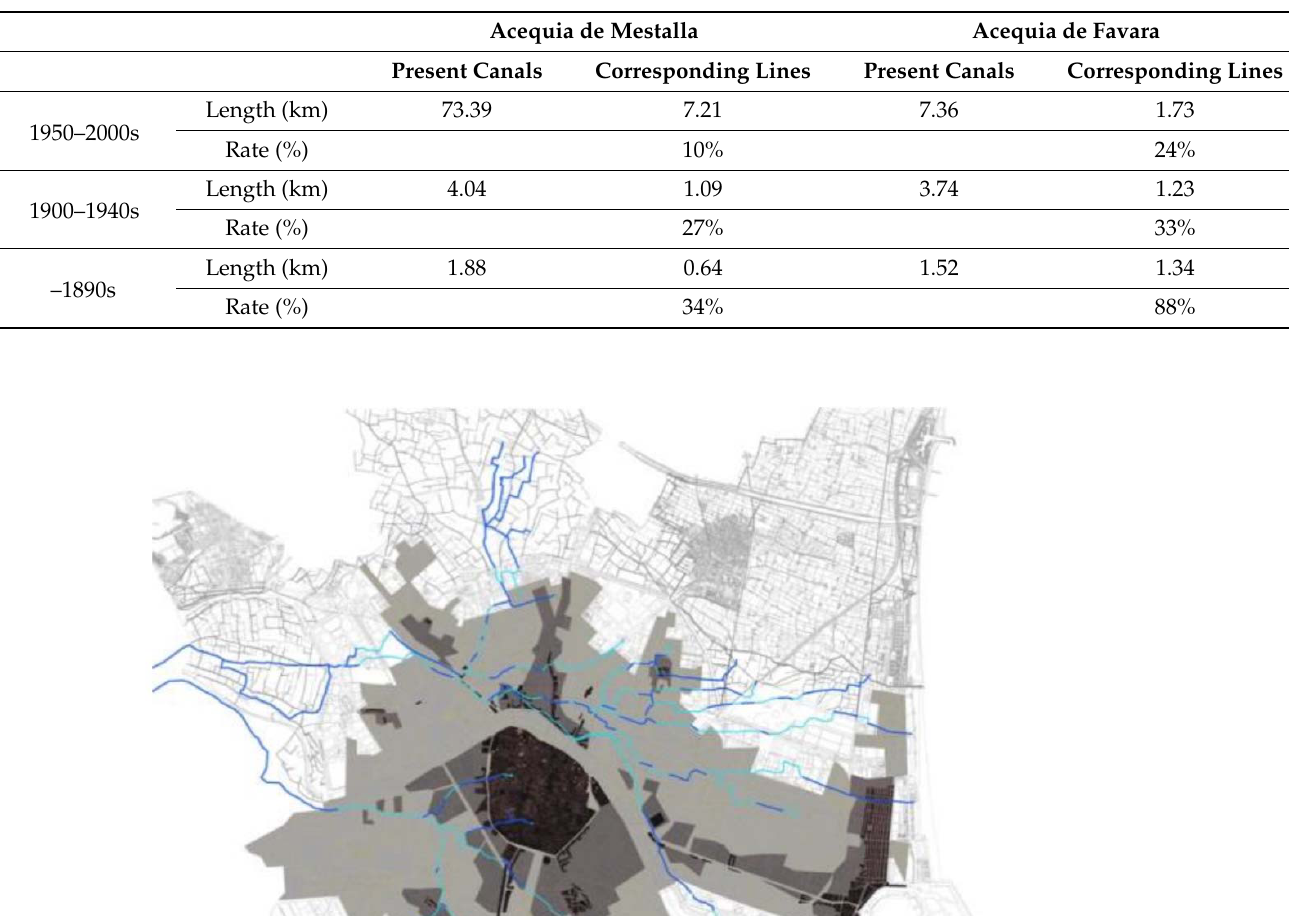
Table 1. The inheritance rate of the irrigation canals in each phase of urbanization.